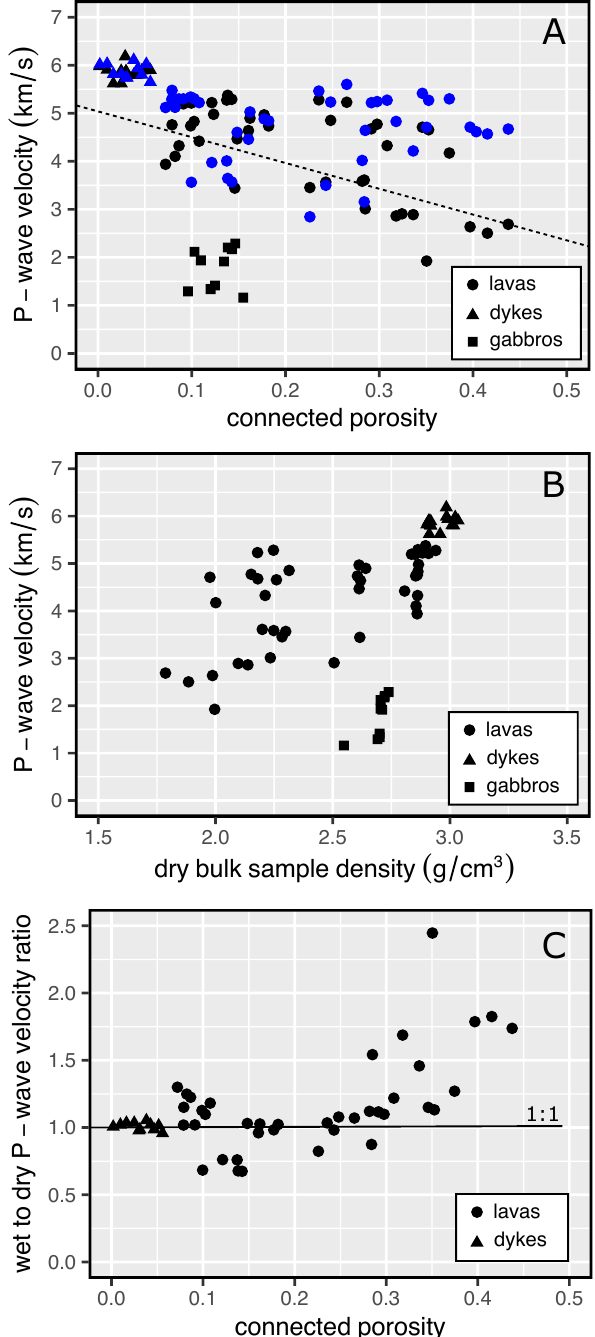
Figure 6: [A] Dry (black symbols) and wet (blue sym- bols) P-wave velocity as a function of connected poros- ity for the basaltic rocks from La Réunion collected for this study (data available in Table A1). The dashed line is the best-fit line of the dry P-wave velocity data. [B] Dry P-wave velocity as a function of dry bulk sample